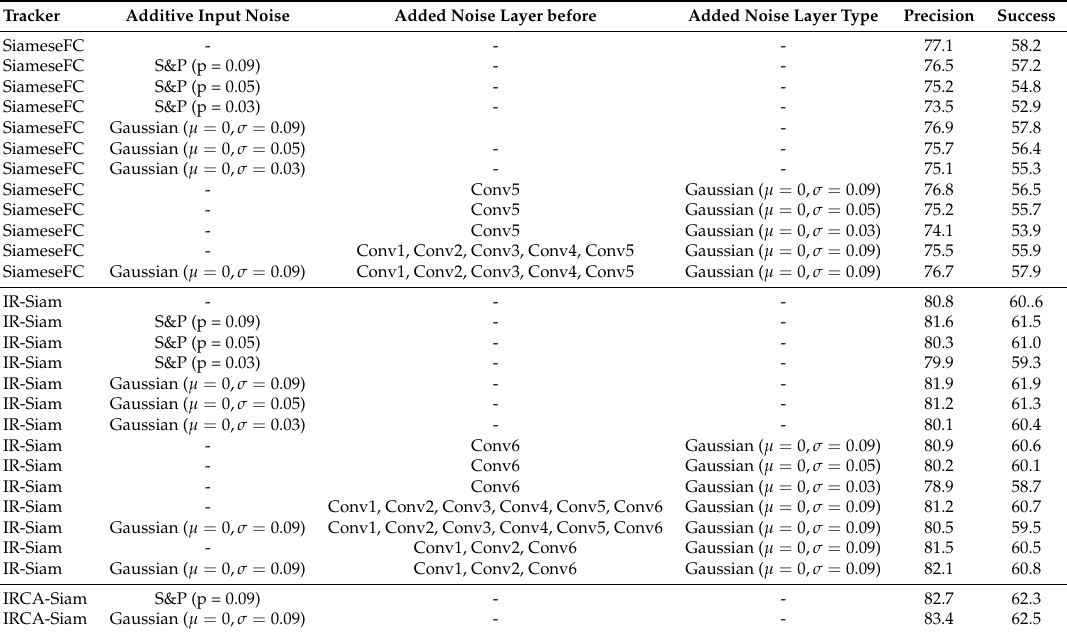
Table 6. Ablation study performed over OTB2015 using precision and